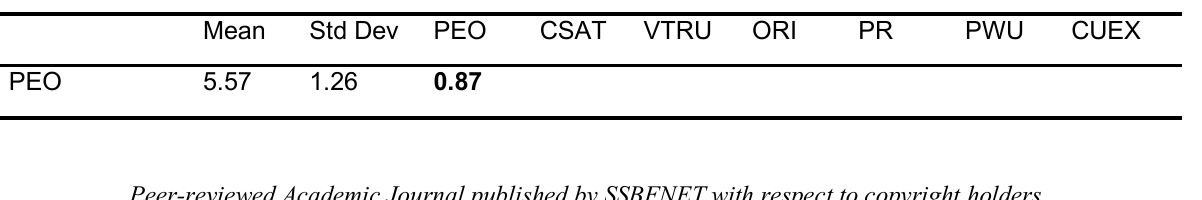
Table 1: Correlational Matric between